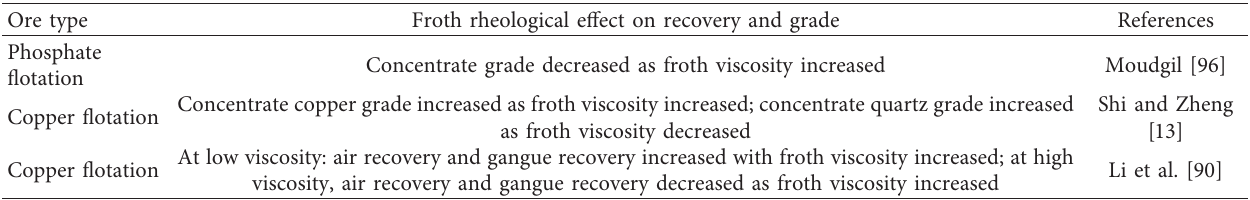
Table 3: Literature related to froth rheological effects on flotation recovery and grade.